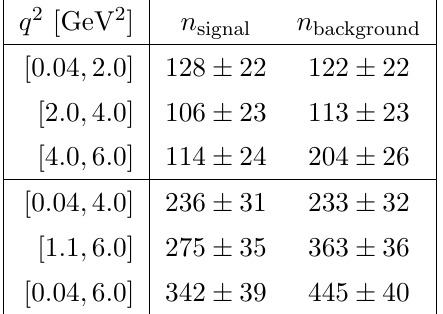
Table 1 . The values of (cid:12)tted signal, n di(cid:11)erent bins in q 2 . The uncertainties indicated are statistical.